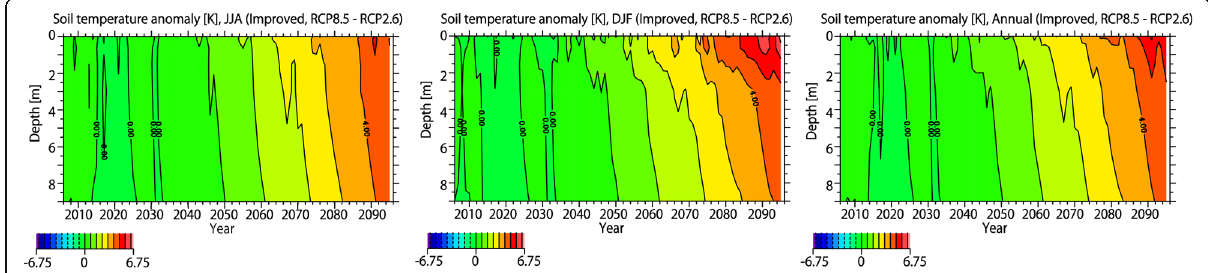
Fig. 8 Difference in soil temperature between RCP2.6 and RCP8.5. The time sequences of the vertical distribution of soil temperature for JJA, DJF, and annual average are shown. Vertical axis represents the soil depth [m], and the longitudinal average of the soil temperature north of 50° is